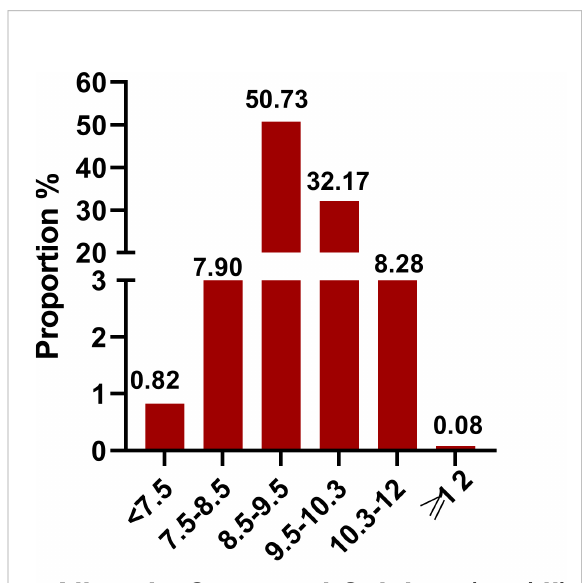
FIGURE 2 Distribution of albumin-corrected calcium. It shows a normal distribution according to strati fi ed range of values.